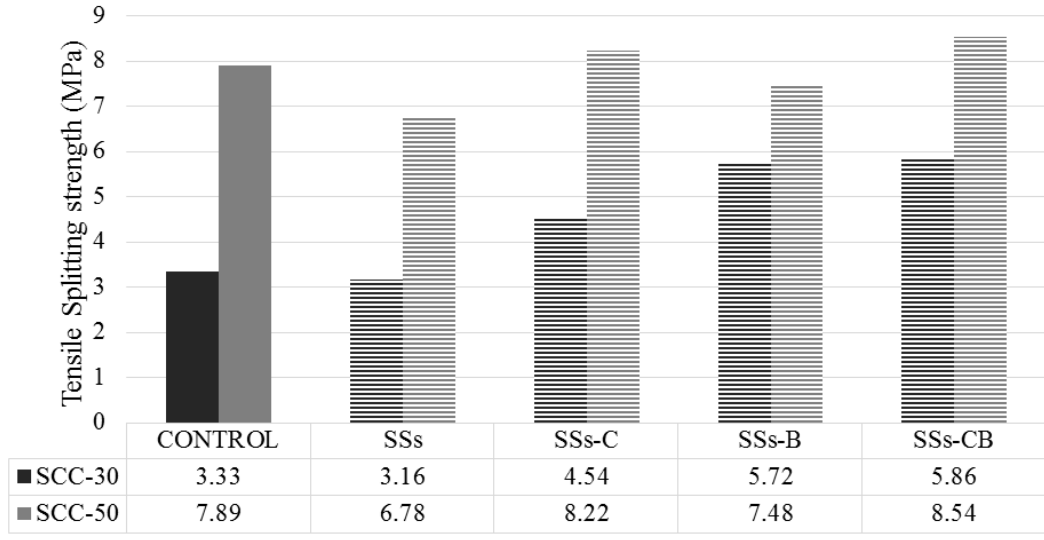
Figure 5. Tensile Splitting strength of SCC-30 and SCC-50.